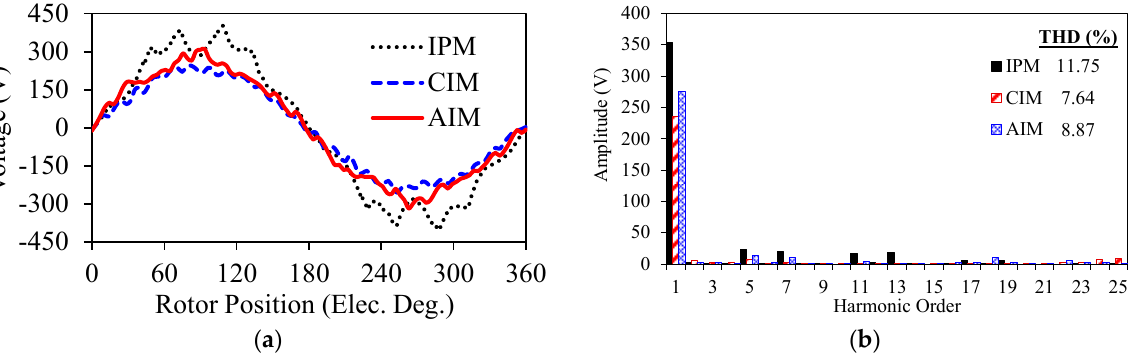
Figure 3. Comparison of back-EMF waveforms and their harmonic spectra. ( a ) Line Back-EMF and induced voltage waveforms. ( b ) Harmonic spectra of the back-EMF and induced voltage.